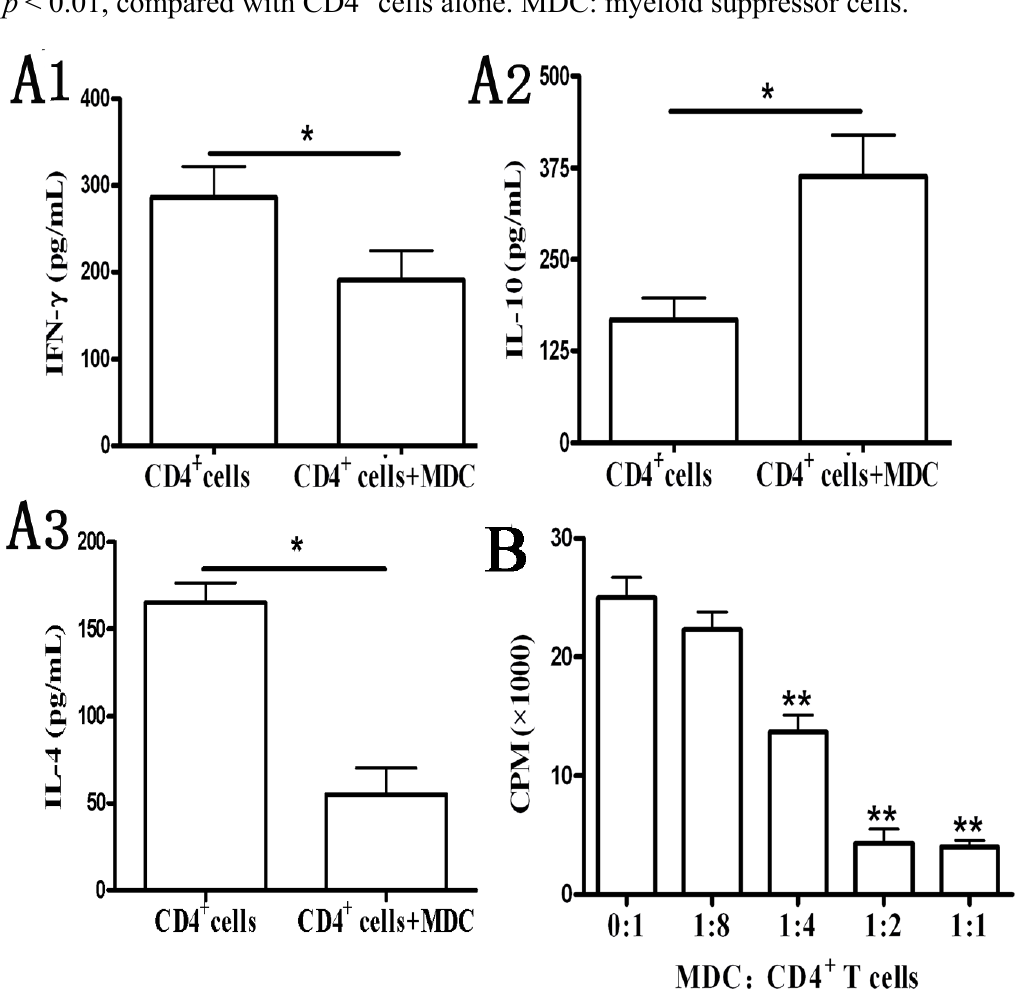
Figure 4. Functional analyses of CD11b + Gr-1 + myeloid suppressor cells in galectin-9-treated mice. Splenic CD4 + T cells from normal BALB/c mice were pre-activated with plate-bound anti-CD3/anti-CD28 (both 2 μg/mL) for 24 h. Splenic CD11b + Gr-1 + myeloid suppressor cells were purified on day 7 from Gal-9-treated mice. Pre-activated CD4 + T cells, in the presence of anti-CD3/anti-CD28 stimulation, were either cultured alone or co-cultured at increasing ratios from 1:8 to 1:1 with CD11b + Gr-1 + cells. Both CD4 + and CD11b + Gr-1 + cells were added at 2 × 10 5 /well. Supernatant samples from CD4 + cell culture and CD4 + cell/CD11b + Gr-1 + cells co-culture (1:1) were collected 24 h after adding myeloid suppressor cells, and the concentrations of various cytokines were examined. ( A1 – A3 ) Proliferation assay was performed after 24 h; and ( B ) Similar results were obtained in three separate experiments. Data show the mean ± SEM. * , p < 0.05; ** , p < 0.01, compared with CD4 + cells alone. MDC: myeloid suppressor